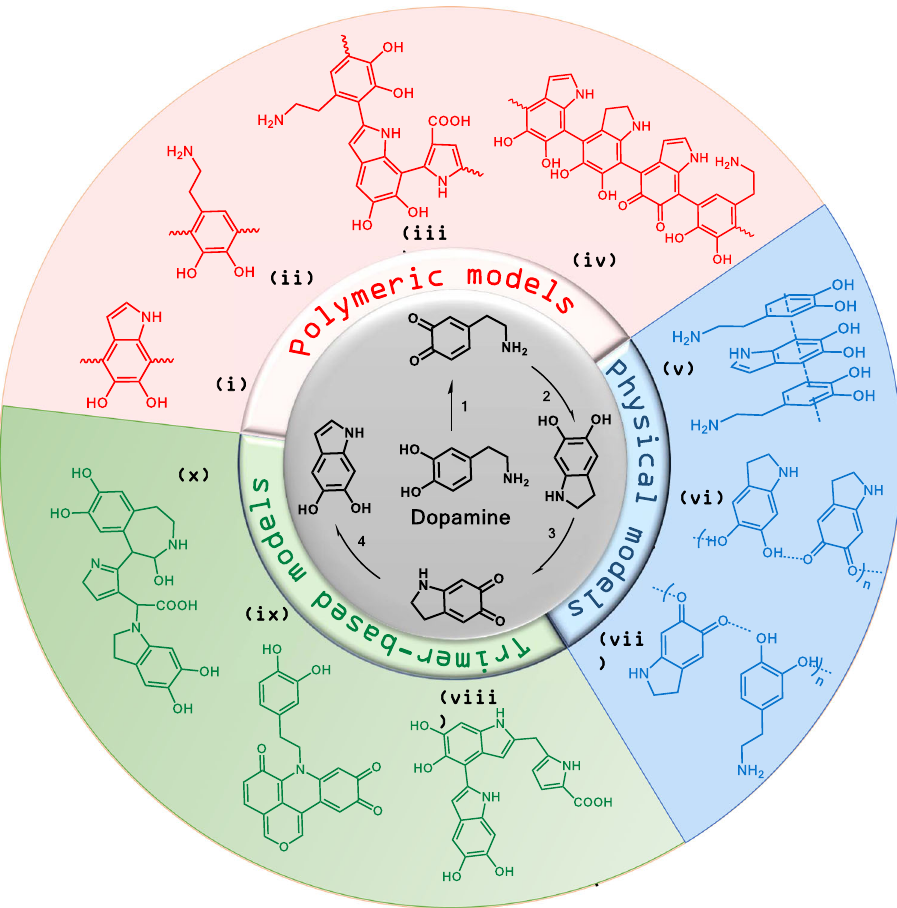
Fig. 1 | Structural models for polydopamine. In the center: the fi rst step in the polydopamine formation process consists of (1) auto-oxidation of dopamine, (2) intramolecular cyclization, (3) oxidation, and (4) isomerization. For the structures (i) – (x) see